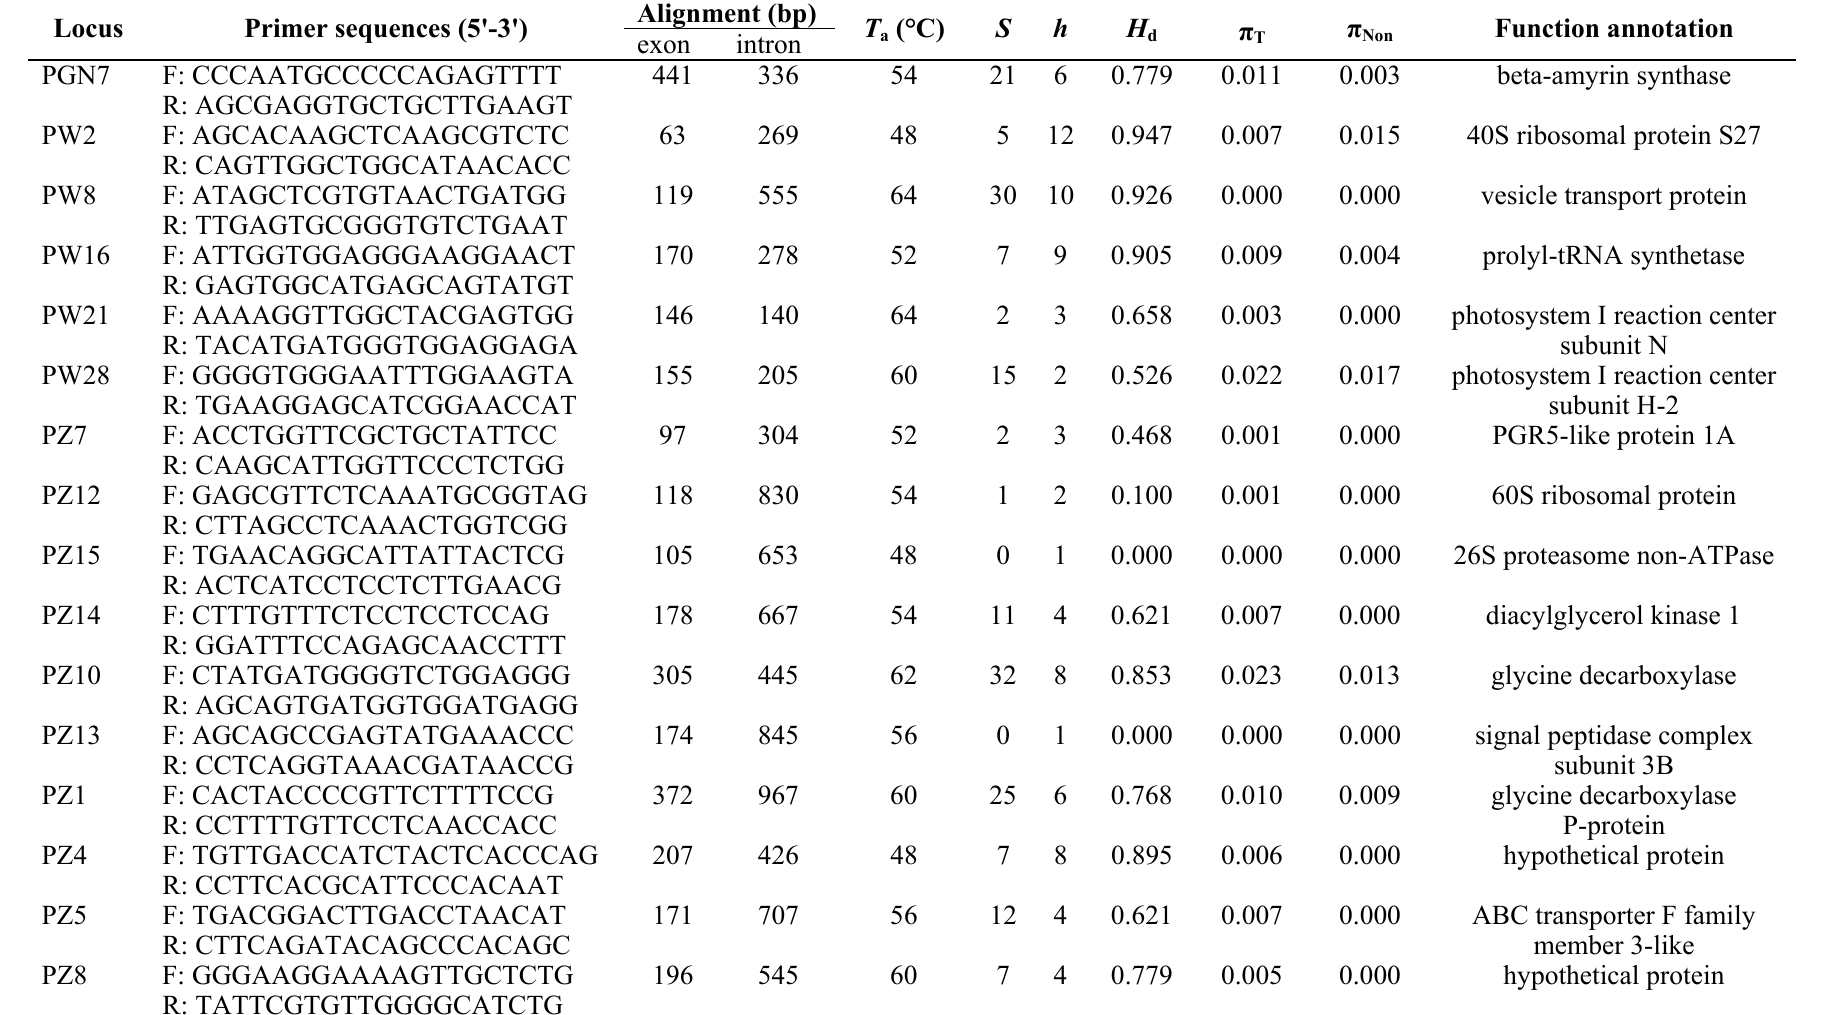
T , annealing temperature; S , number of segregating sites; h , number of haplotypes; H a π , nucleotide diversity for nonsynonymous Non